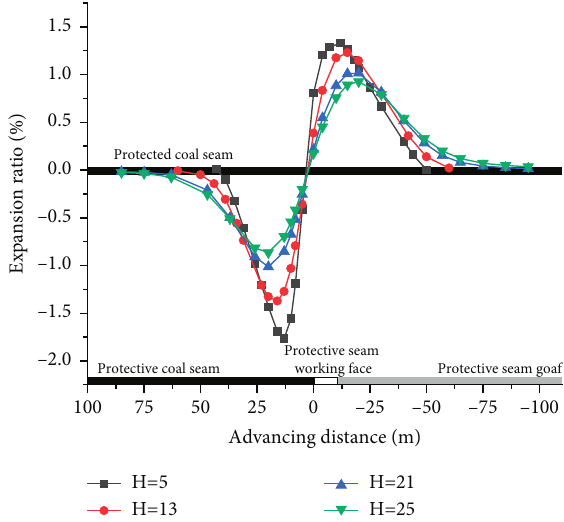
Figure 11: Variation curve of expansion rate at different buried depths.